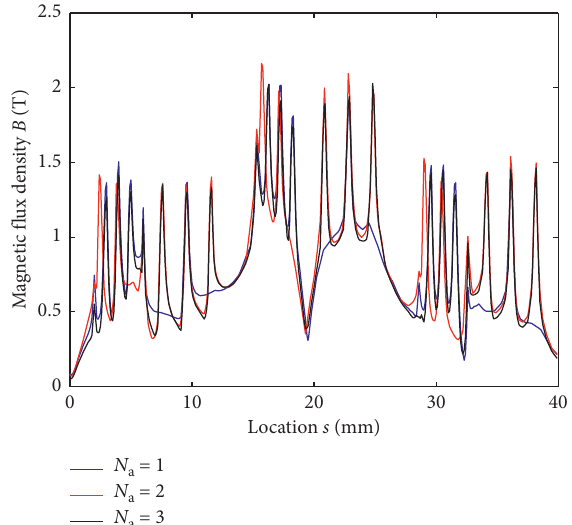
Figure 11: Effect of teeth number on sealing capability. N teeth number.